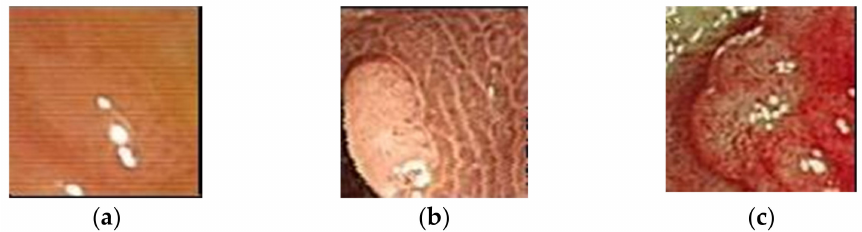
Figure 2. Different polys in endoscopy: ( a ) hyperplastic polyps; ( b ) adenoma; ( c )